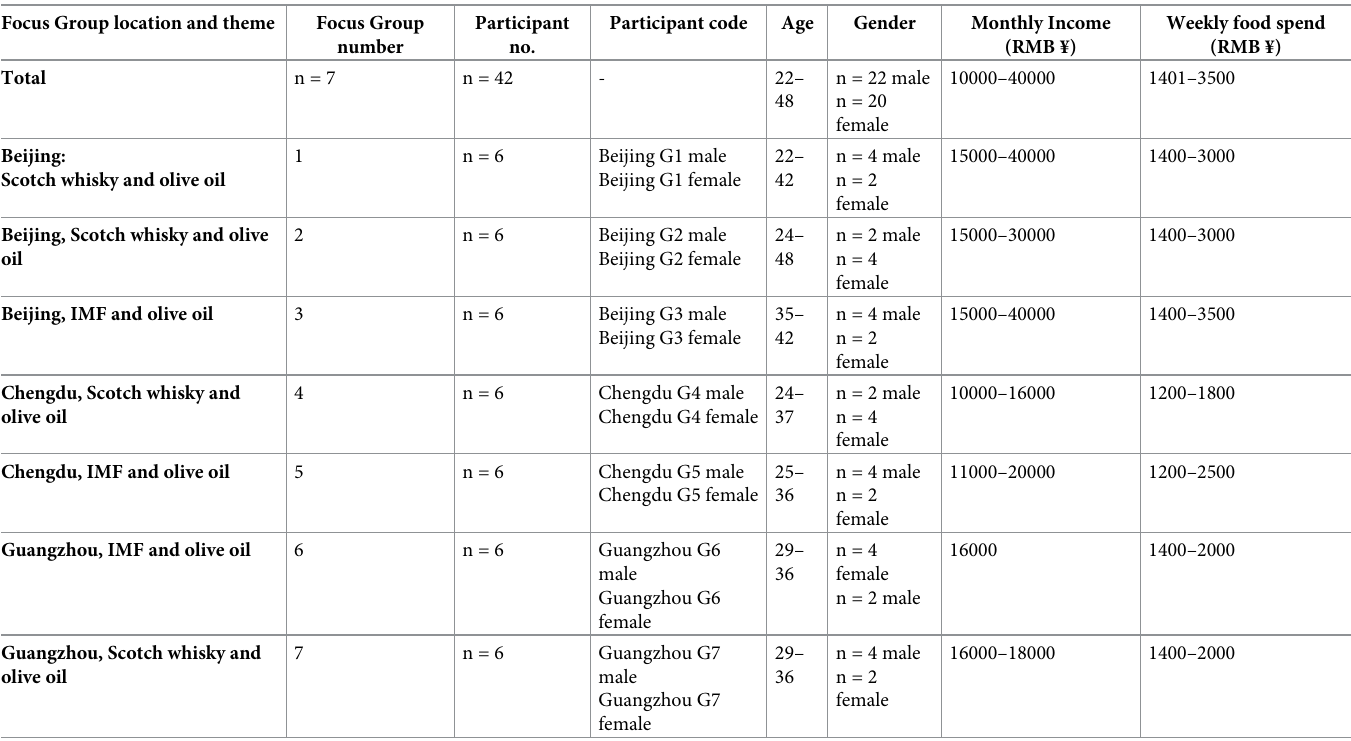
Table 3. Focus group sample